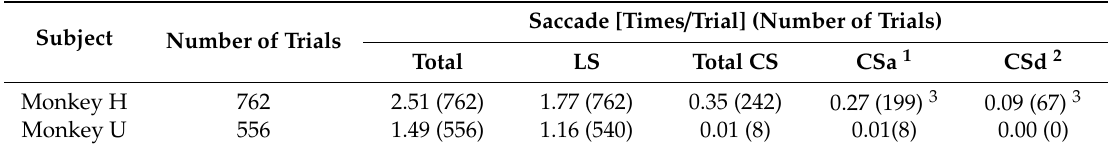
Figure 2. Two types of saccades during the hitting task are depicted. ( A ) leading saccade (LS) occurs almost simultaneously at the onset of acceleration of the cursor. ( B ) catching saccade (CS) follows LS in this trial. Table 1. Occurrence probability of each type of saccades during the hitting task.